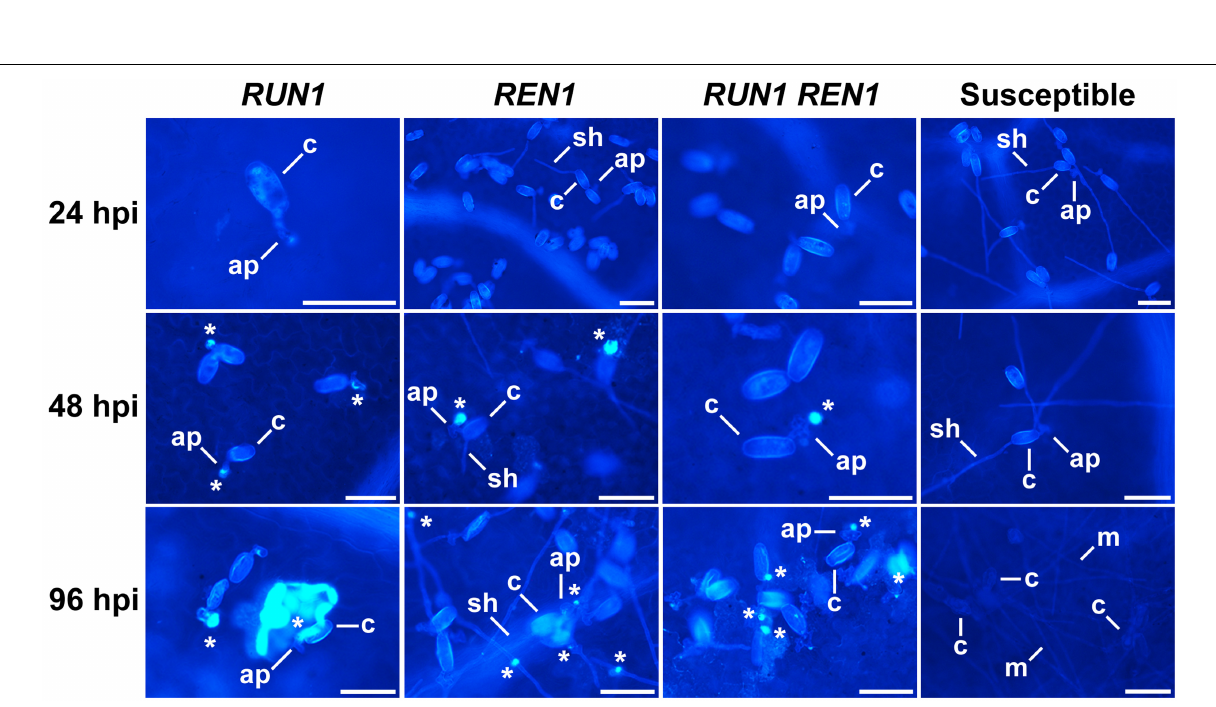
FIGURE 5 | Accumulation of callose deposits at the E. necator infection site in segregating grapevine plants carrying RUN1 and/or REN1 loci. Samples were collected at 24, 48, and 96 hpi; c, conidium; ap, appressorium; sh, secondary hypha; m, mycelium; asterisks indicate bright-blue fluorescent callose accumulation in response to infection; scale bar, 50 µ